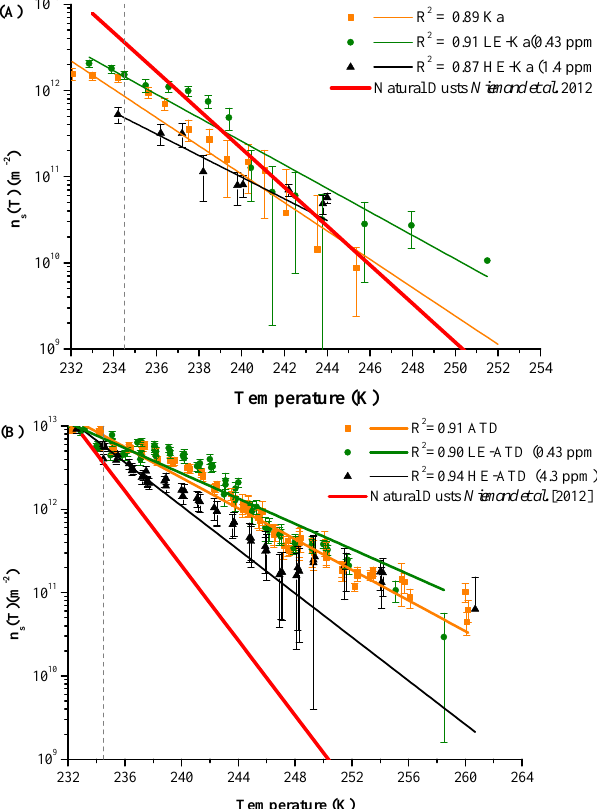
Fig. 9. Ice-active surface site densities as a function of temperature for deposition mode at RH w = 95% (A) Ka and (B) ATD. Expo- nential fit functions to data are presented in Table 5.